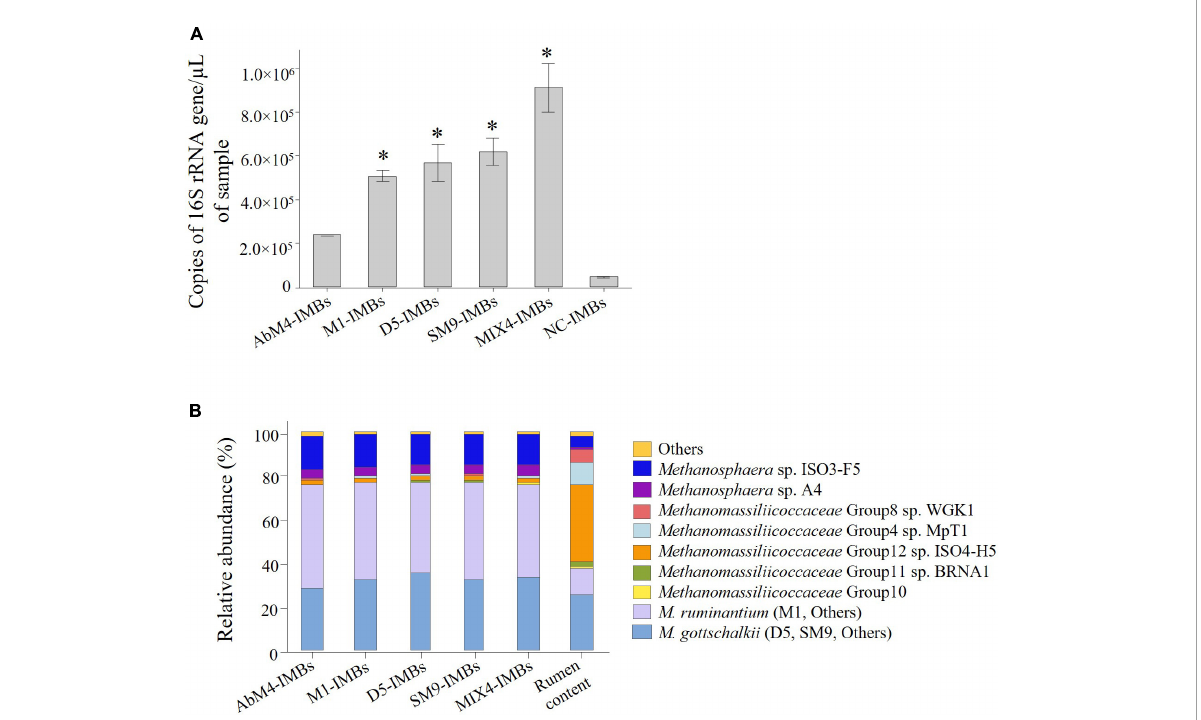
FIGURE5 IMBs used to capture methanogens from rumen content samples. 1 × 10 8 IMBs coated with antibodies produced against M. ruminantium M1, Methanobrevibacter sp. AbM4, Methanobrevibacter sp. D5, Methanobrevibacter sp. SM9, a mixture of all four methanogens (MIX4), or negative control (NC) sera were used to capture methanogen cells from rumen content samples. (A) Genomic DNA was isolated from captured cells and quantified by qPCR using primers to amplify 16S rRNA gene. Copies of 16S rRNA gene/ µ L of sample are plotted against types of IMBs used to capture the cells. NC-IMBs were used as a serum control, while rumen content only samples were used to get the total count of cells present in the initial sample. Data are presented as means ( ± SE) of three biological replicates. ∗ Significantly different to negative control (NC-IMBs) group ( P < 0.05). (B) Relative abundance of different methanogens captured by IMBs in rumen content